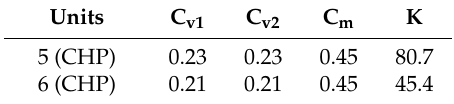
Table 4. The thermoelectric relationship coe ffi cient of thermoelectric units.